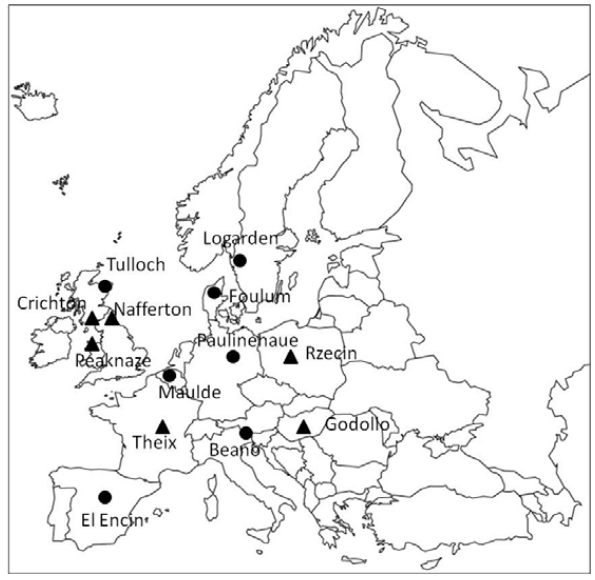
Fig. 1. Locations of the European experimental sites. Circles repre- sent arable sites and triangles grassland